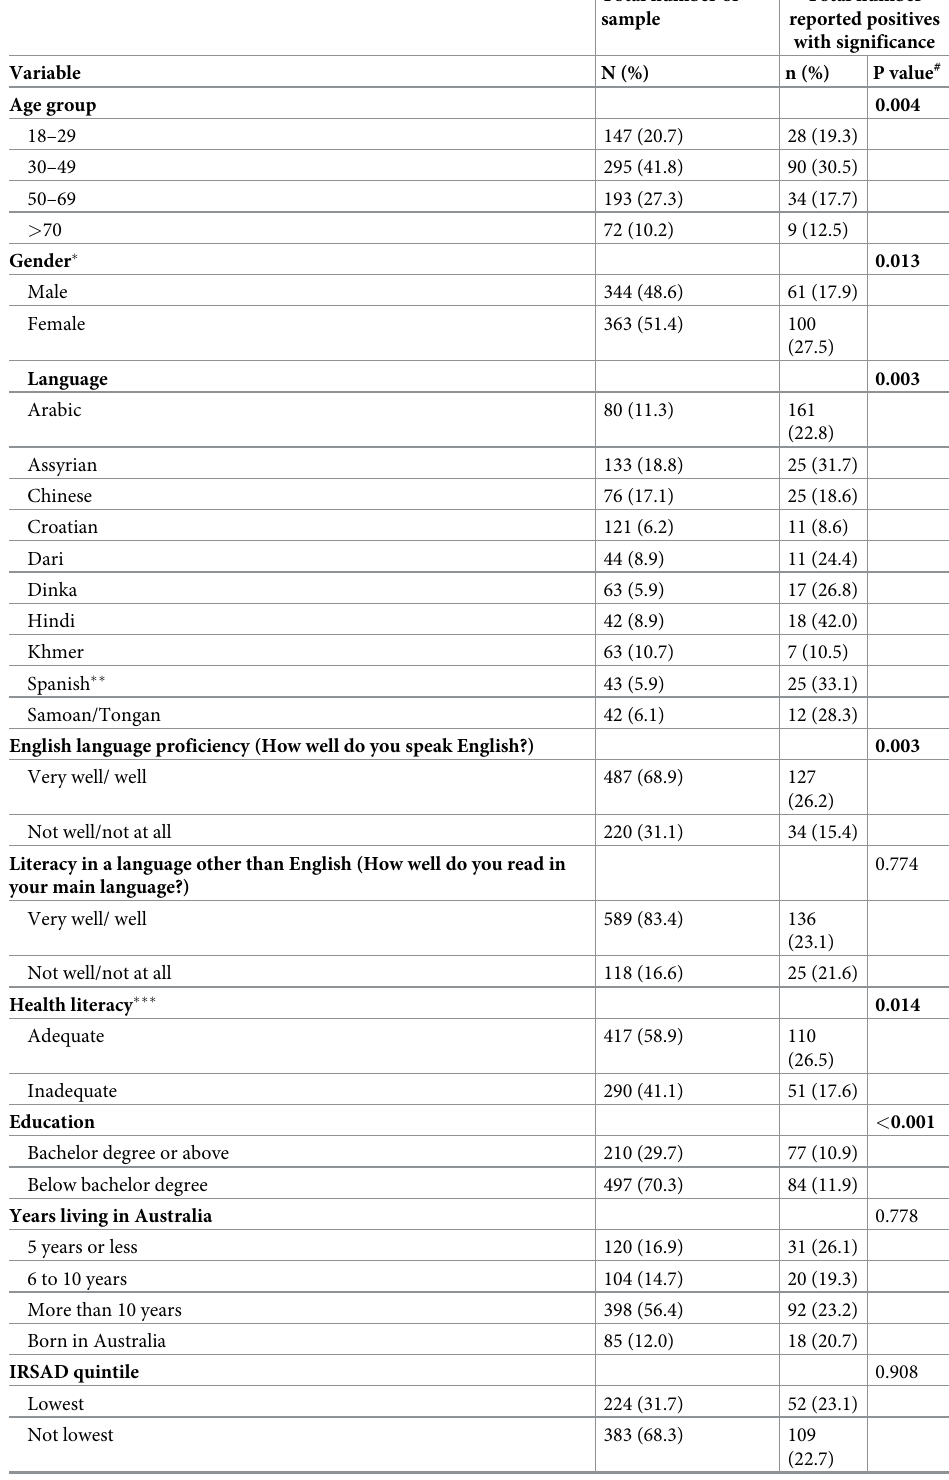
Table 1. Descriptive statistics of the total sample and those who reported